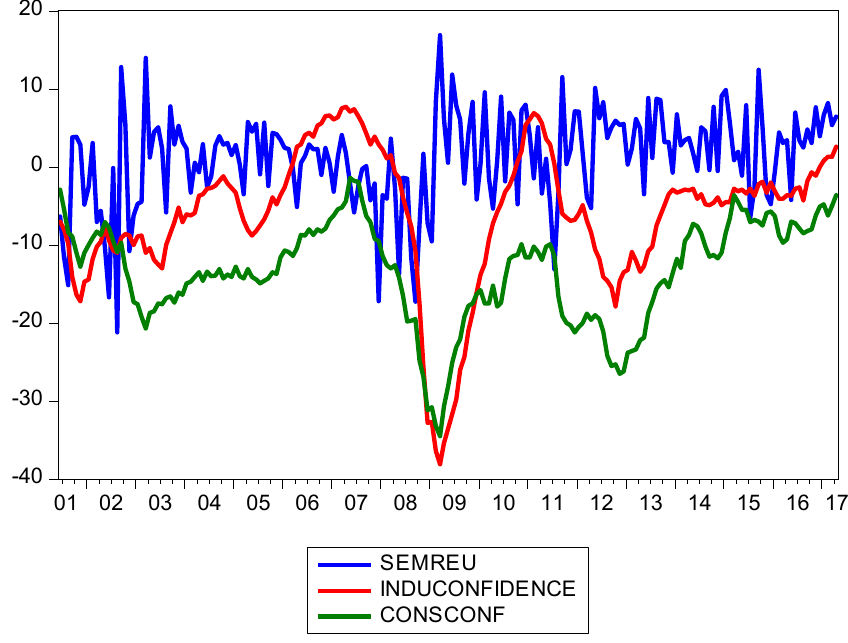
Figure 4. Plot of the economic indices, CONSCONF and INDUCONF, and the stock market returns, SEMREU, for the entire range 2001–2017.